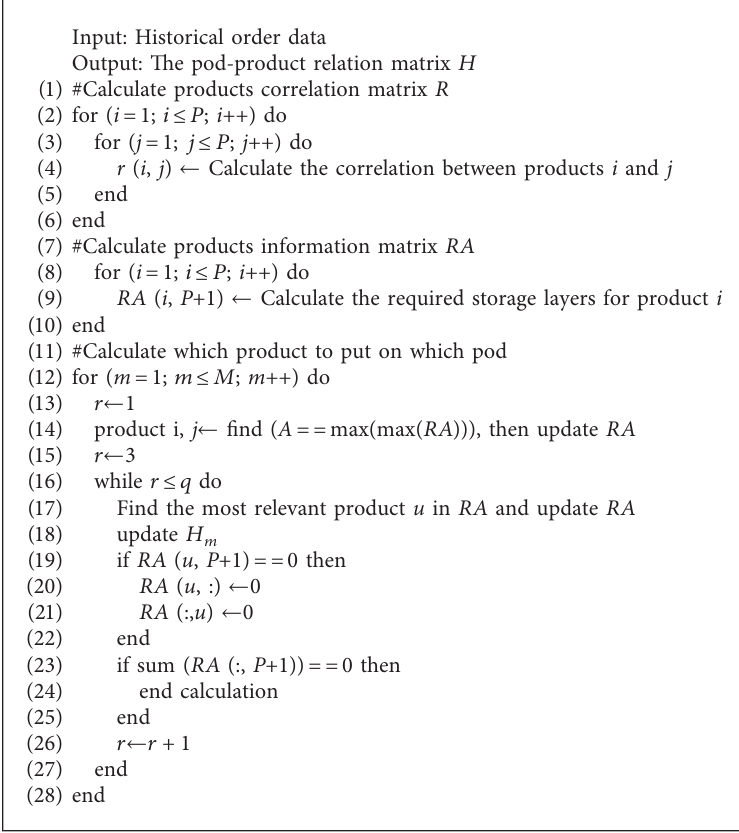
algorithm combining greedy algorithm and simulated